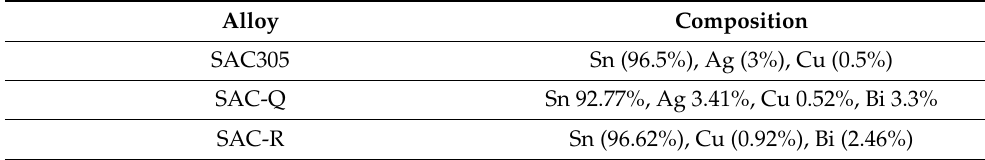
Table 1. Composition of the solder